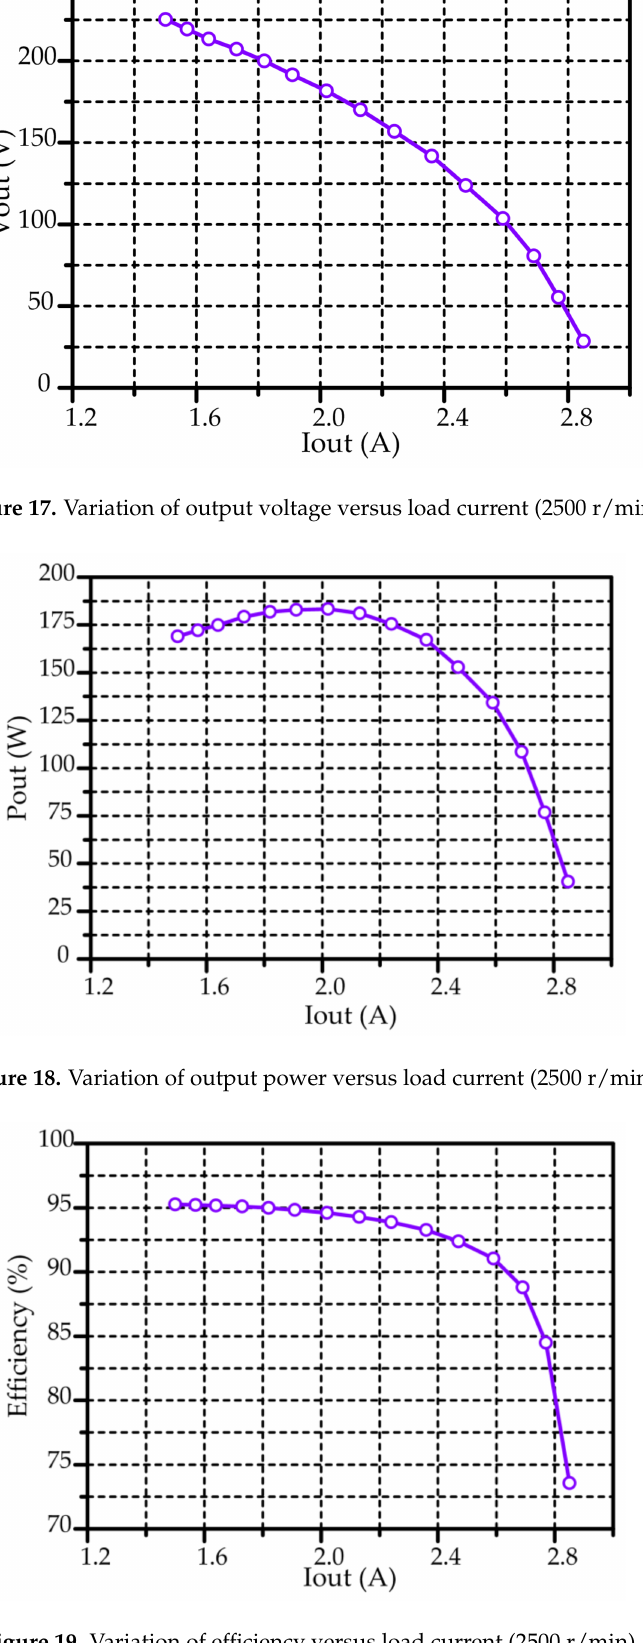
Figure 19. Variation of efficiency versus load current (2500